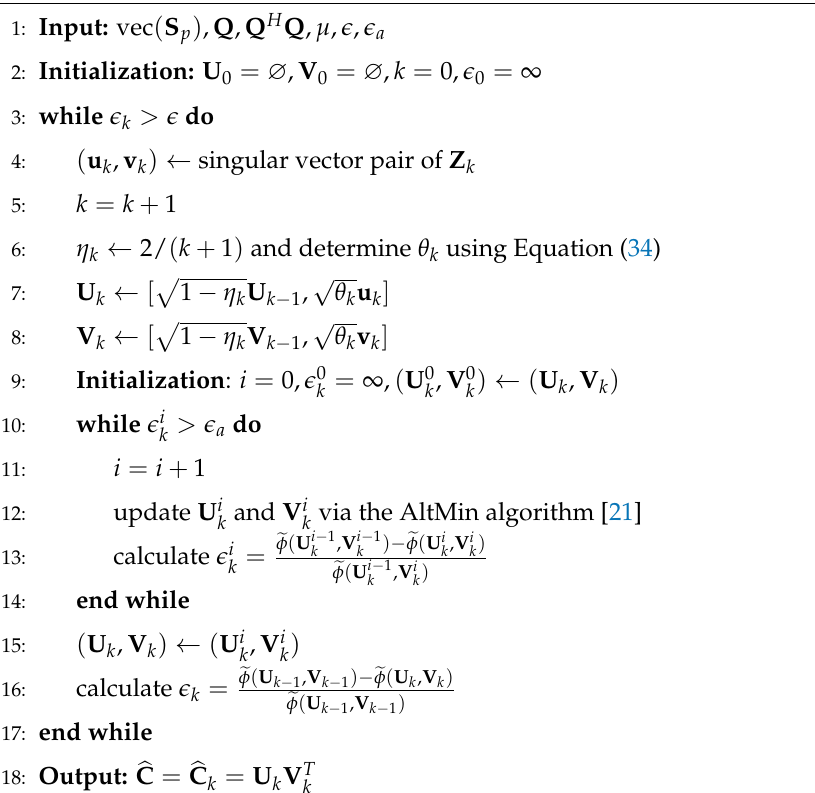
Algorithm 1 The GCG-Alt Algorithm for Estimating (cid:98) C of Equation